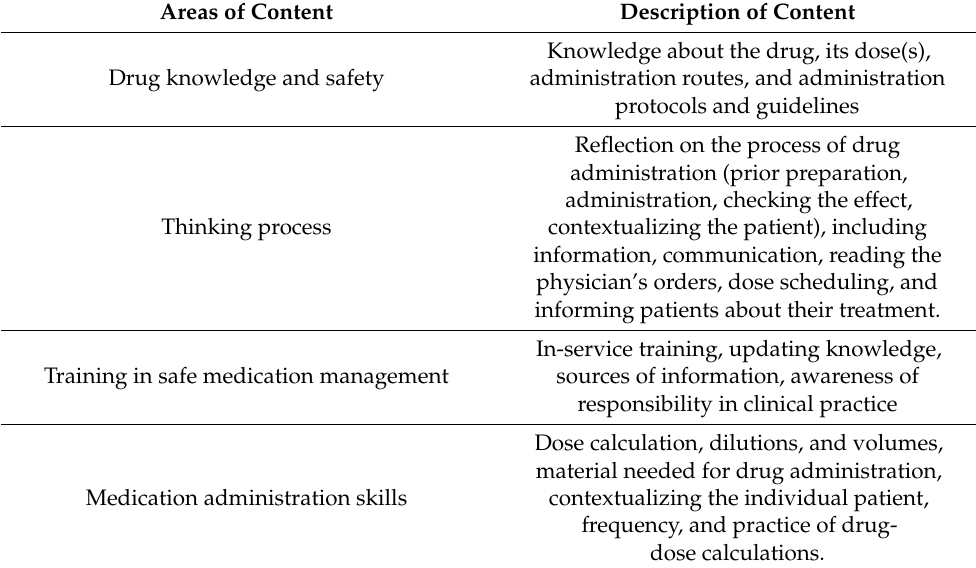
Table 1. General areas of